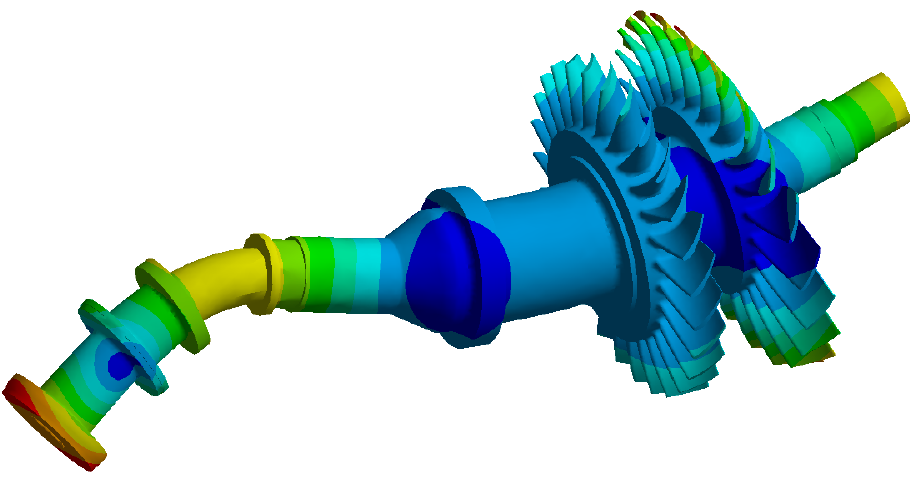
Figure 6. A typical mode shape of TRT rotor.